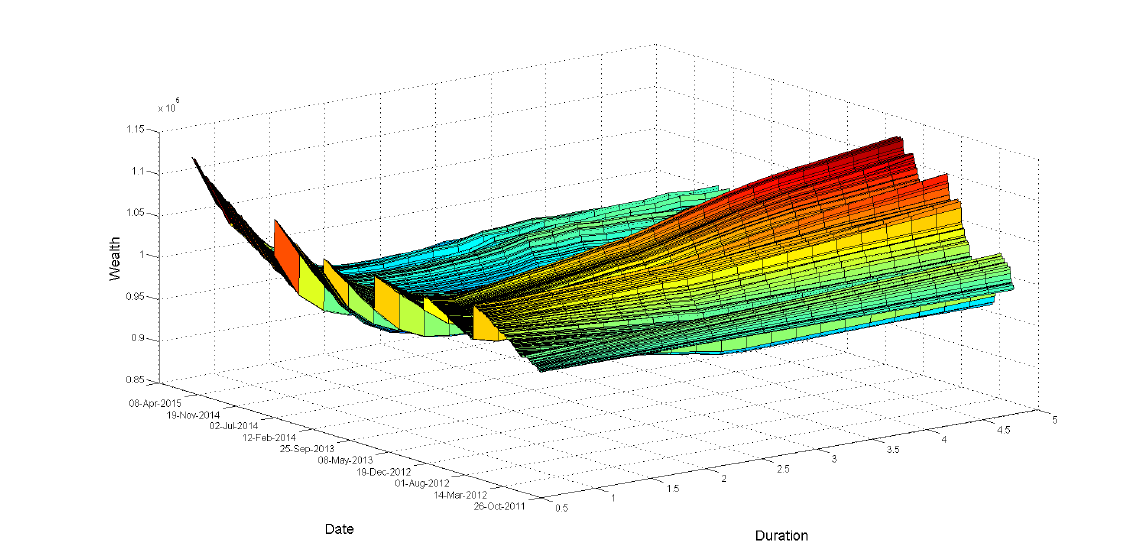
Figure 1. Ex-post wealth on Brazilian bond portfolios after first phase (October 2011–April 2015)